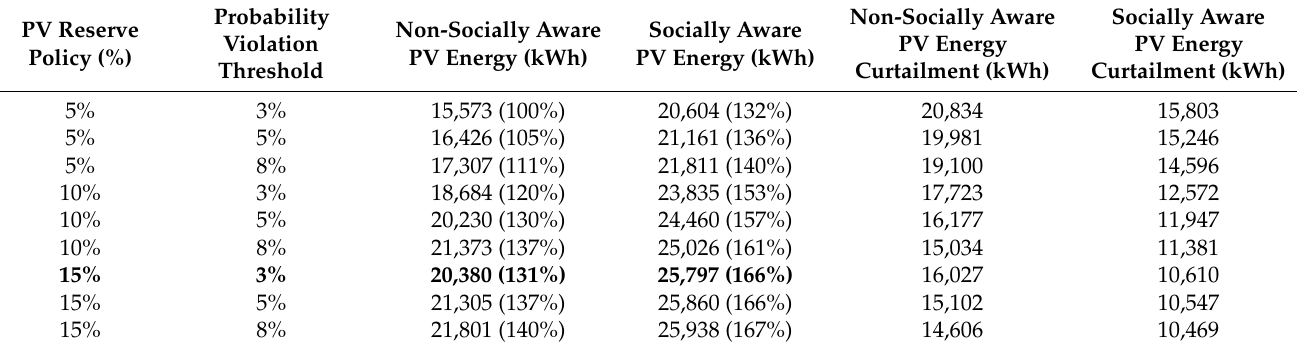
Table 2. Total Scheduled PV Energy for Case II.